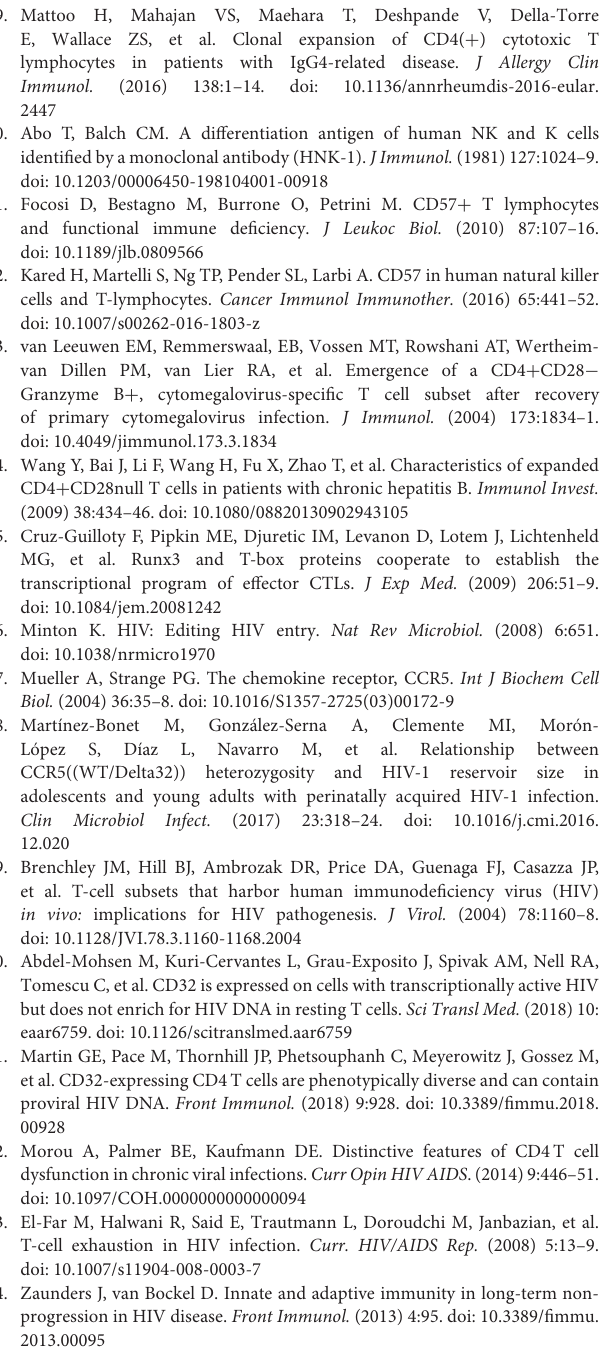
upregulation in Target cells (T) after anti-CD3 activation of CD57 + Effector cells (E). (C–E) Killing of target cells by CD57 + Effectors in Healthy controls, ART treated PHI and ART treated CHI, respectively. ∗ p < 0.05, ∗∗ p < 0.01, ∗∗∗∗ p < 0.0001. Supplementary Figure 8 | Maintenance of CD57 + function in EC. (A) Dot plot representing IFN γ expression 6h post stimulation with SEB, CMV and gag. (B) No difference in IFN γ expression between EC and VC in CD57 −